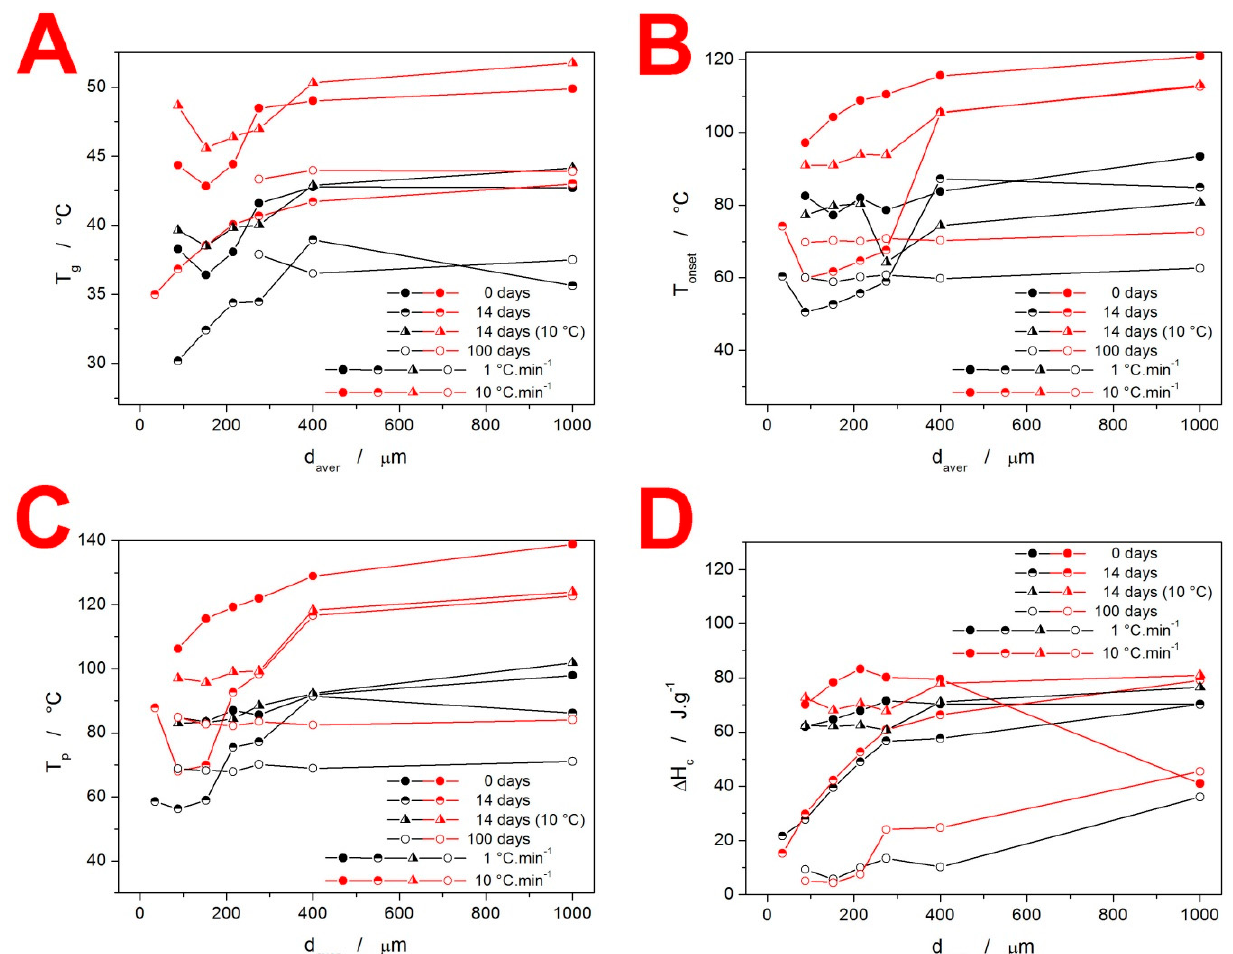
Figure 5. Base characteristic quantities (glass transition temperature T g —( A ), the onset temperature of the crystallization peak T onset —( B ), the peak temperature of the crystallization peak T p —( C ), and crystallization enthalpy Δ H c —( D ) obtained at chosen q + for the IMC powders stored under different